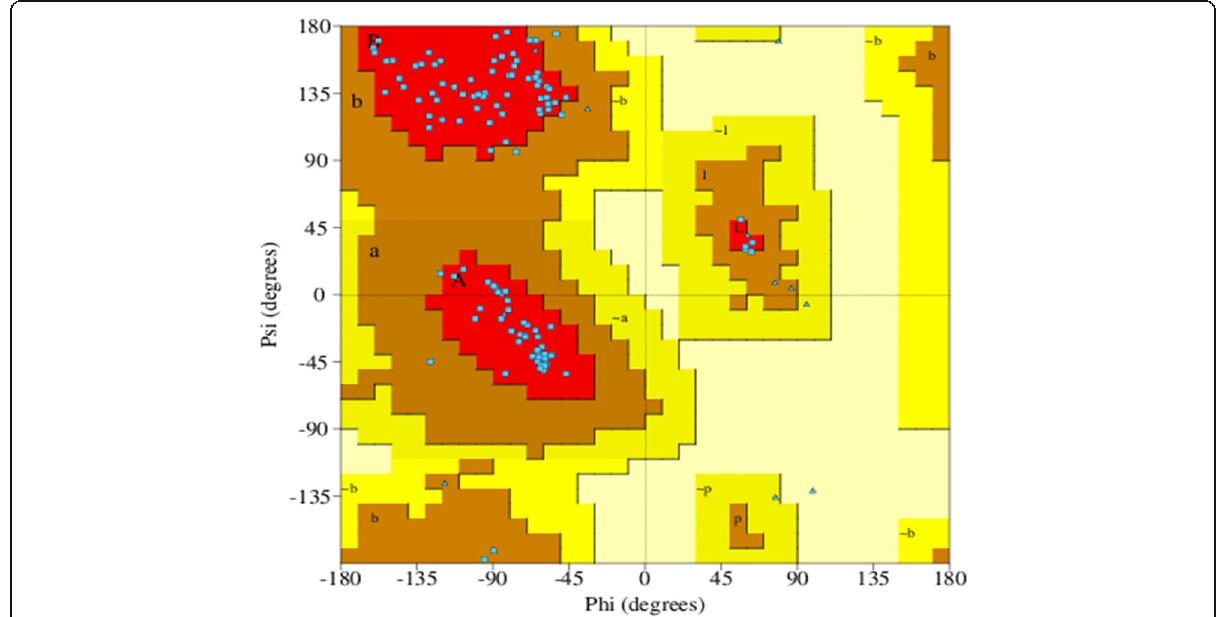
Fig. 18 Ramachandran plot of S.AMP 13 using